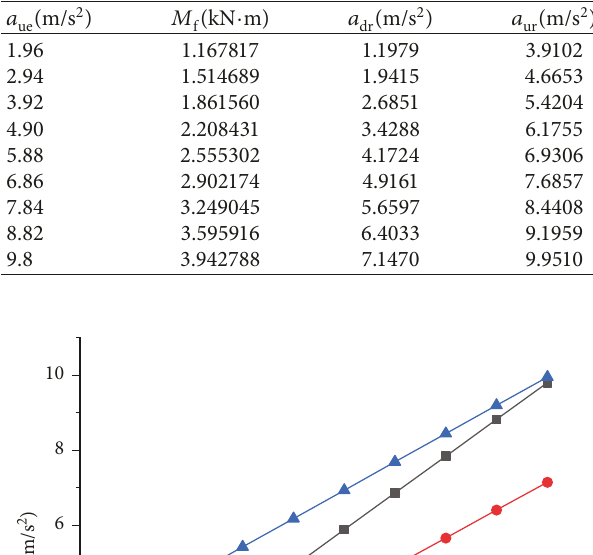
Table 3: Braking torque—acceleration relation